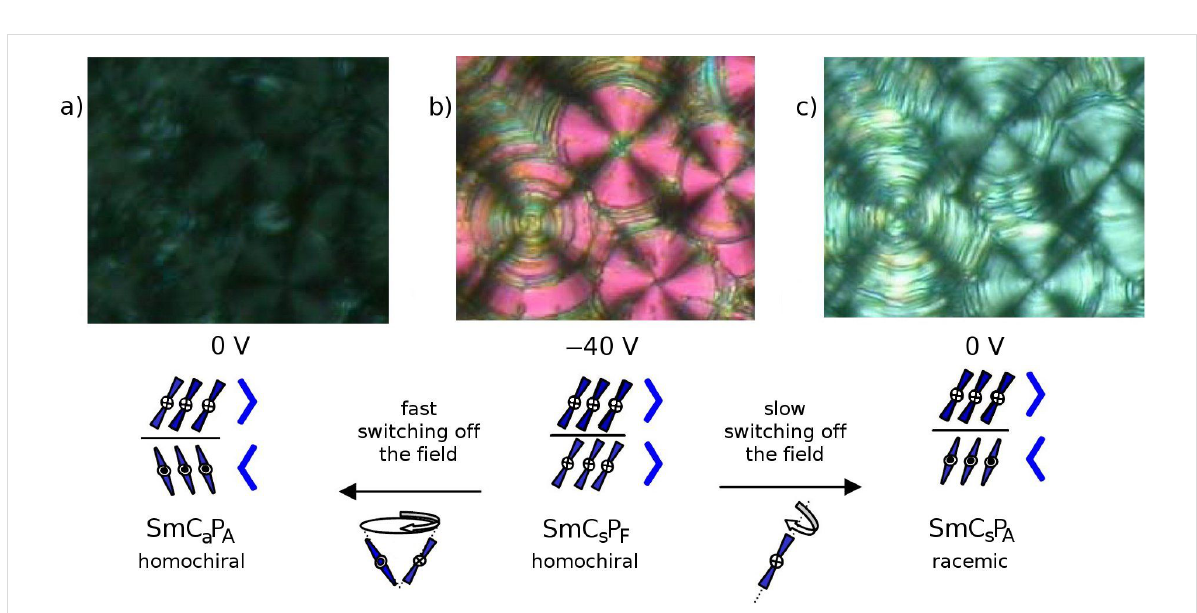
Figure 4: Switching behaviour of compound H 1a , which depends on how quickly the electric field is switched